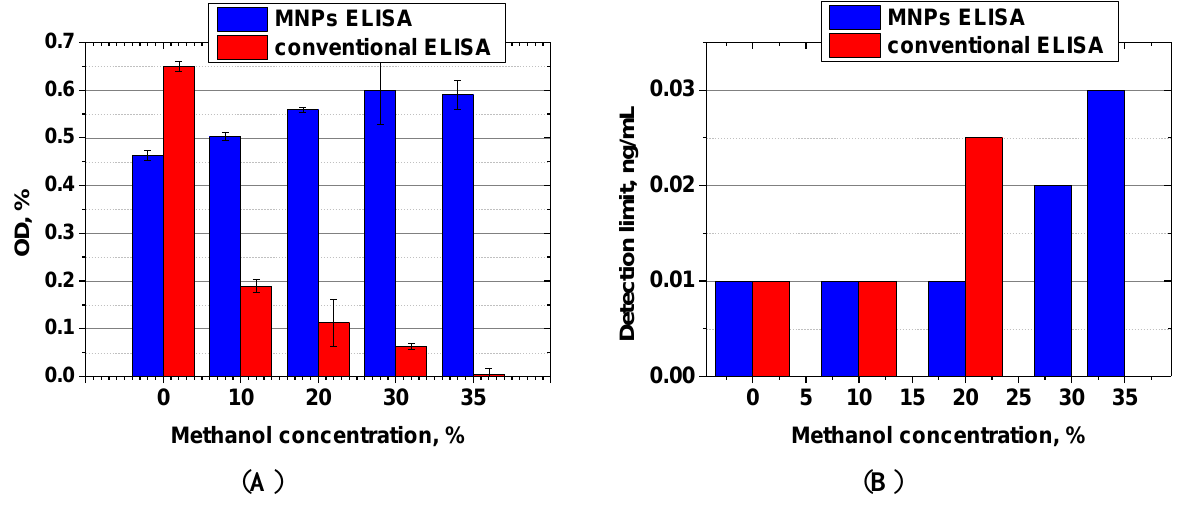
Figure 5. Influence of methanol content on signal intensity ( A ) and limit of AFB1 detection for ELISA ( B ) for MNP-based ELISA (green bars) and microplate-based ELISA (red bars). For microplate ELISA, ≥30% methanol content produced insufficient label binding for reliable competitive detection of AFB1, whereas MNP-based ELISA was still reliable. The measurements were performed in